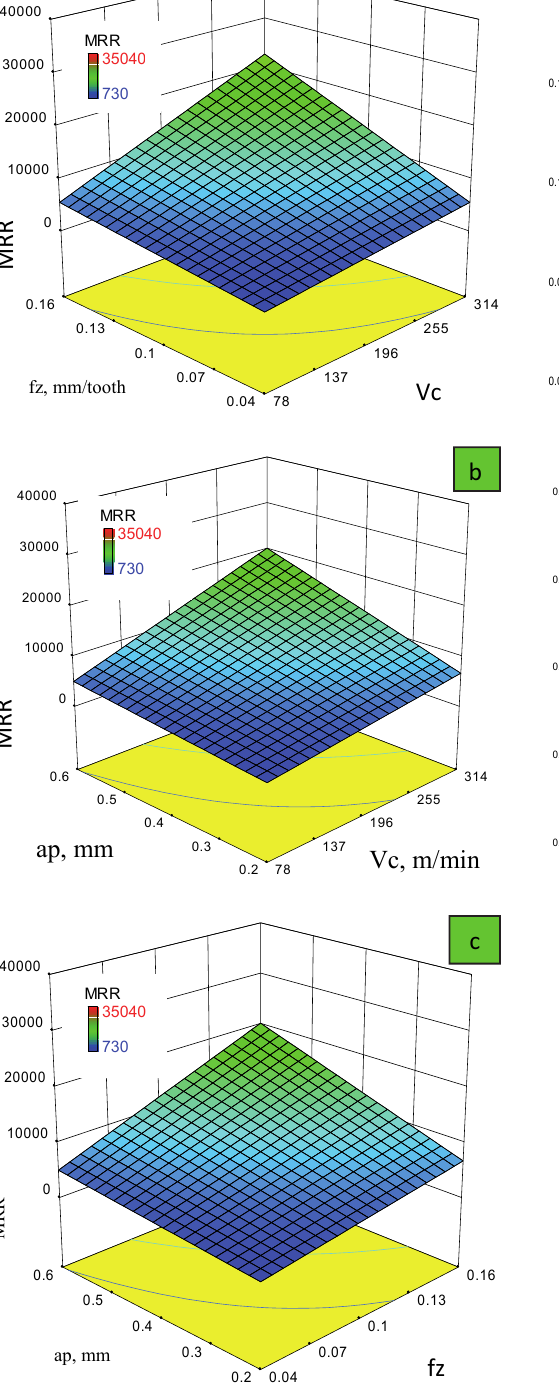
Fig. 9. Contour plot of MRR = f (V c , fz,